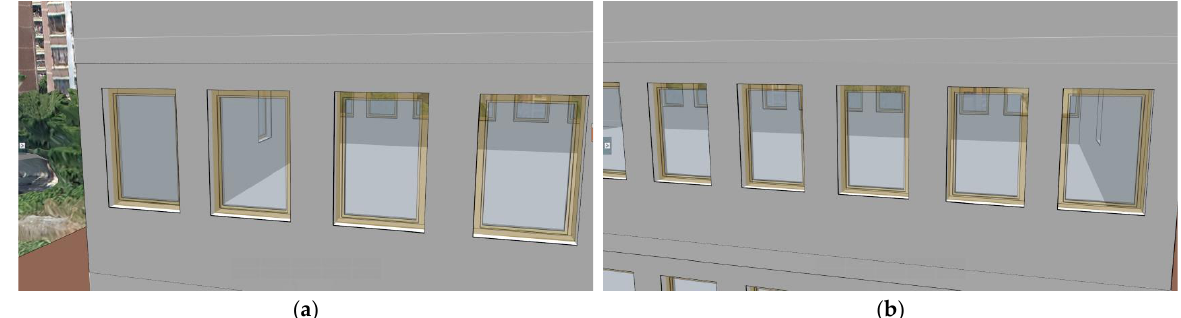
Figure 11. Experimental areas (within green dashed lines) for testing outdoor scenes. Using the Liu et al. (2016) method (Figure 12), when the viewpoint is located outdoors, interior building entities cannot be loaded when observing through a window. In contrast, using the proposed method, interior entities corresponding to the window are loaded when the viewpoint is close to the model and there is a transparent window (Figure 13).